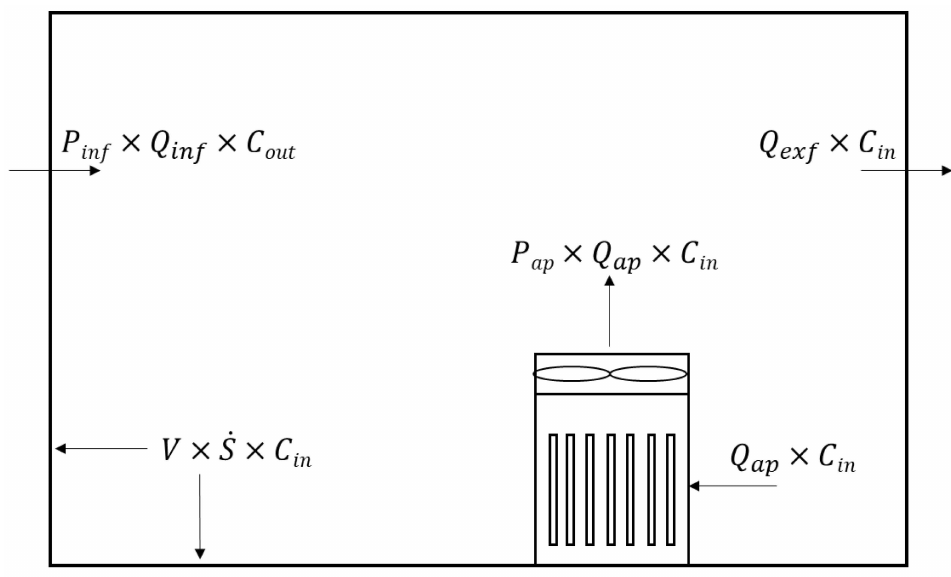
Figure 1. Schematic diagram of indoor particle dynamic process with an air purifier in a